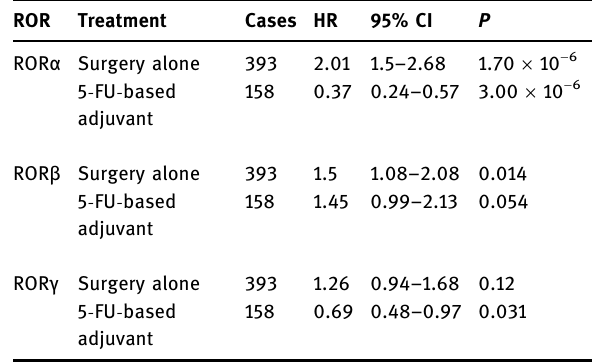
Table 4: Correlation of RORs mRNA expression with di ff erent treatment methods of patients with